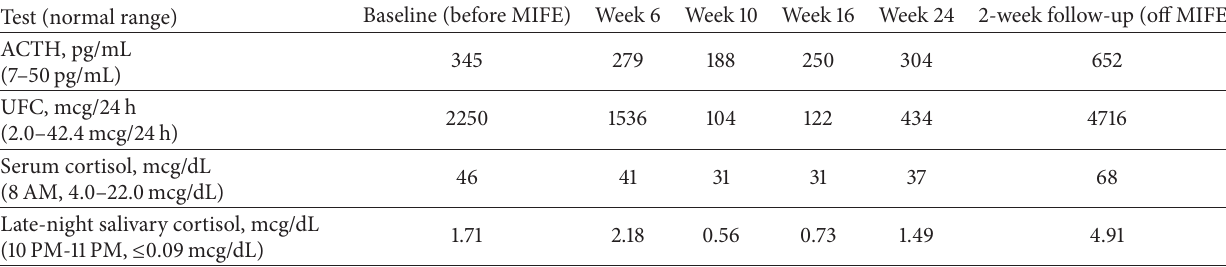
Table 1: Biochemistry evaluations during treatment with mifepristone ∗ .